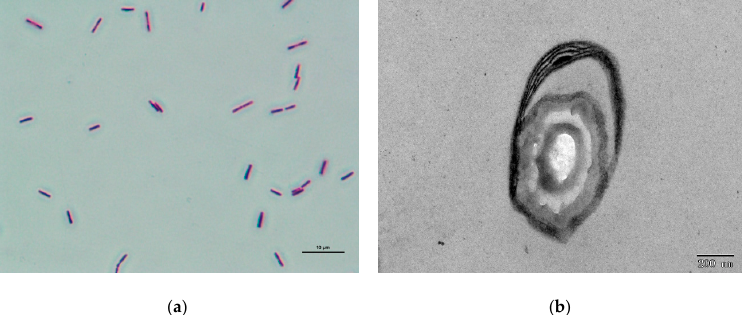
Figure 4. ( a ) Light micrograph of strain CT32 cell morphology; ( b ) transmission electron microscopy image of strain CT32 endospore.